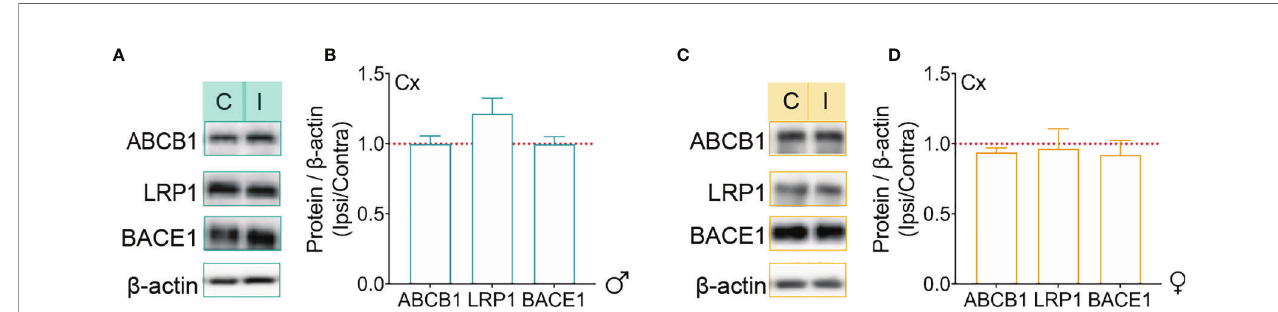
FIGURE 5 | Mechanisms of A b production and clearance are not affected by microinfarct induction. (A) Western blot representation of ABCB1, LRP1 and BAEC1 in the contralateral and ipsilateral cortex of MO-operated male APP/PS1 mice. (B) Western blot analysis of ipsilateral and contralateral expression ratio shows that there are no changes in ABCB1, LRP1 and BACE1 expression in the cortex of MO-operated male APP/PS1 mice. (C) Western blot representation of ABCB1, LRP1 and BAEC1 in the contralateral and ipsilateral and cortex of MO-operated female APP/PS1 mice. (D) Western blot analysis of ipsilateral and contralateral expression ratio indicates that the expression of ABCB1, LRP1 and BACE1 remains unchanged in the cortex of MO-operated female APP/PS1 mice. Statistical analysis was performed by comparing the ratios of ipsilateral/contralateral to 1 (one